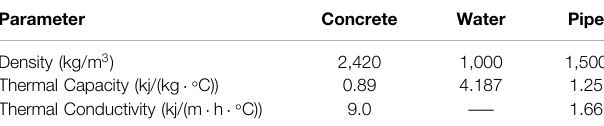
TABLE 1 | Parameters of concrete and water pipe.